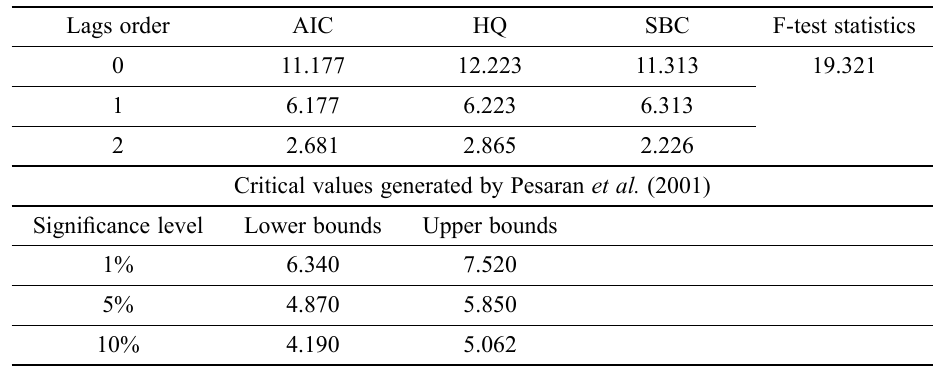
Table 3. Lag length selection & bound testing for